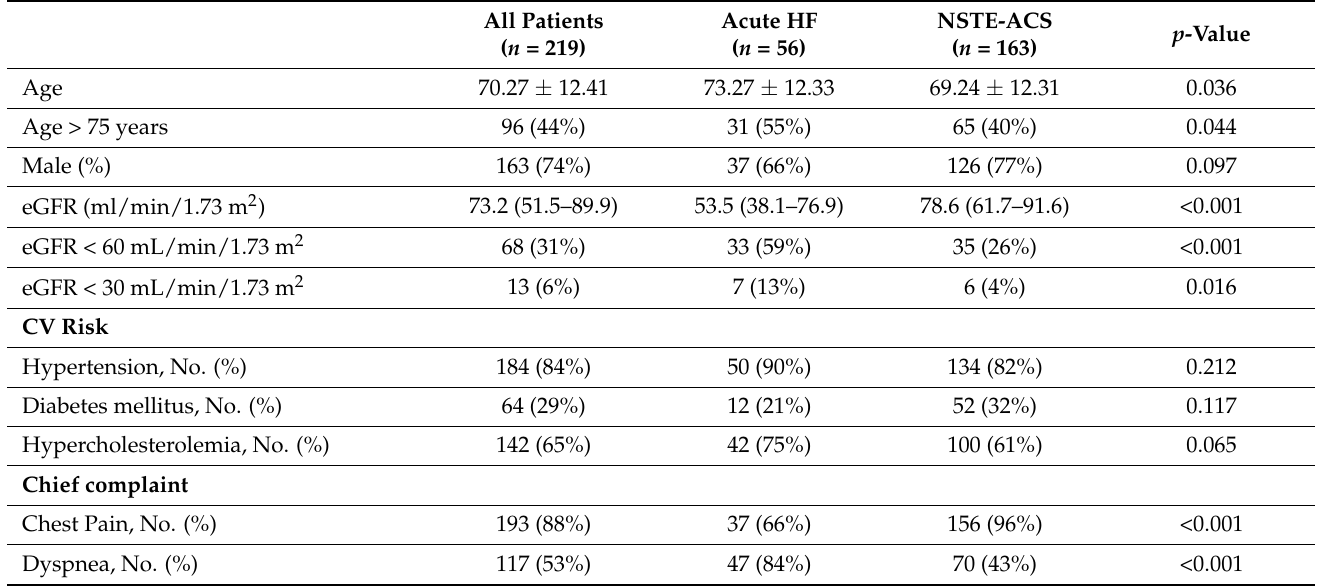
Table 1. Baseline characteristics and laboratory values in the derivation